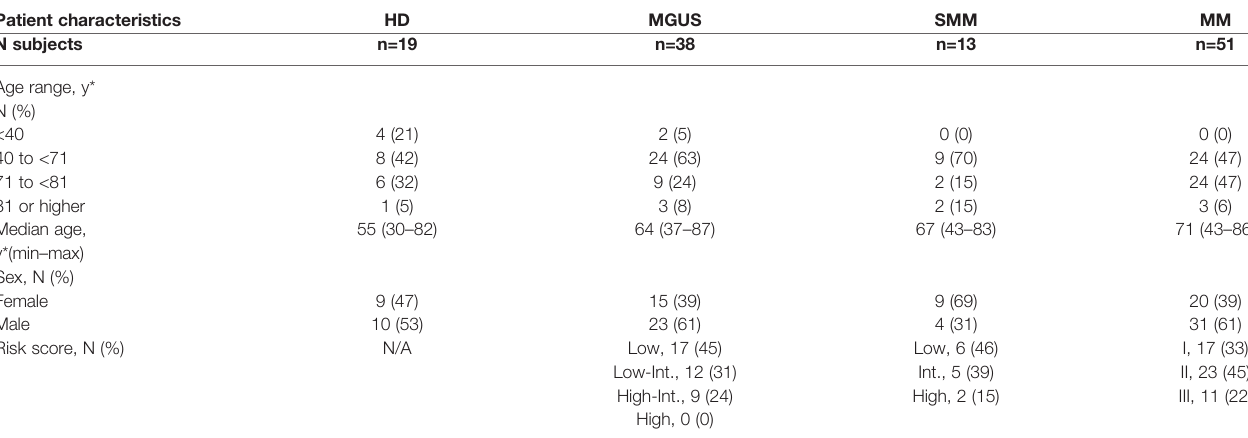
TABLE 1 | Patient characteristics and distribution according to diagnostic category at study entrance. Patient